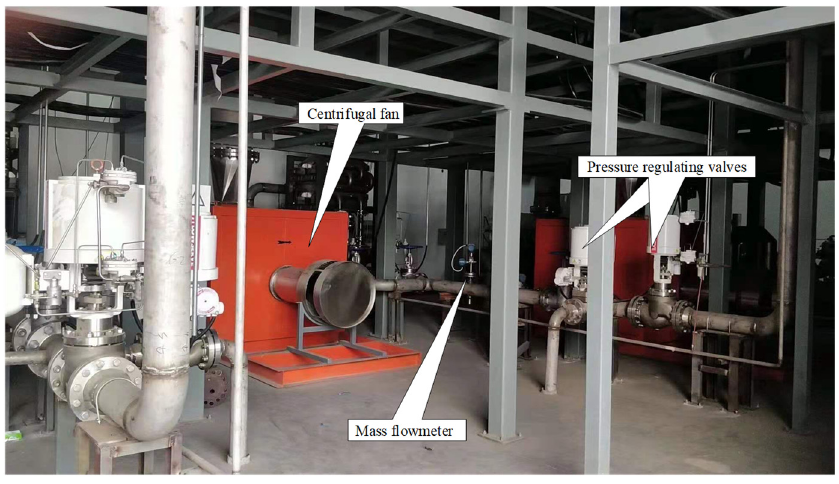
Figure 6. The facility structure.